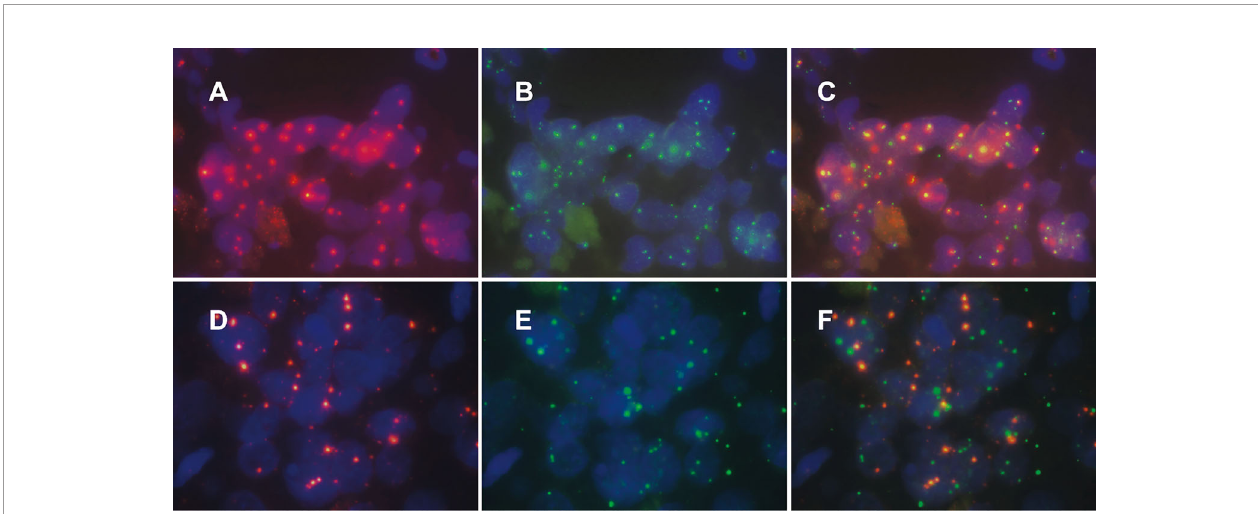
FIGURE 2 | Patterns of human speci fi c chromosomal site probe signals and HPV signals in cervical cancer tissue. Among the cells containing HPV signals, the ratio of cells with colocalized HPV probe signals and speci fi c chromosomal site probe signals was calculated. Samples with a ratio greater than 60% were evaluated